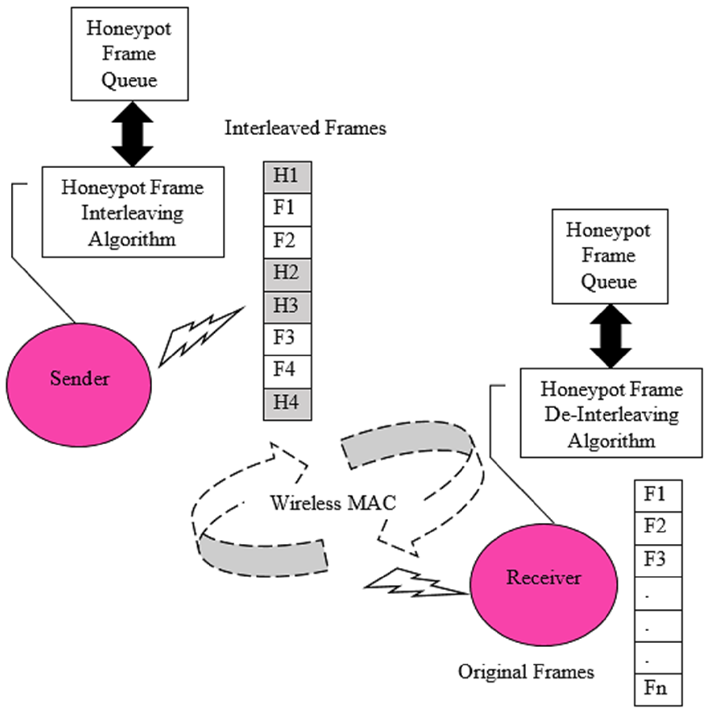
Figure 4. Honeypot frame ‐ interleaving and de ‐ interleaving process.